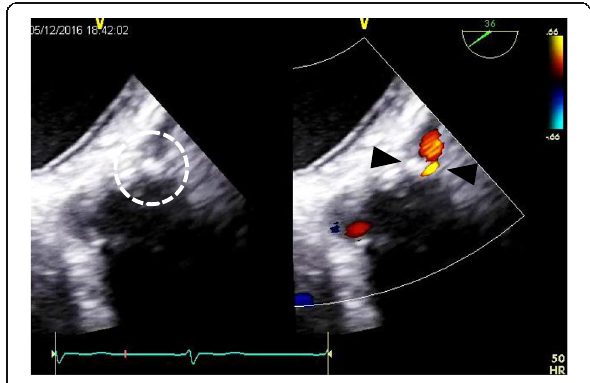
Fig. 3 Intraoperative transesophageal echocardiography. Left , a high- brightness massive shadow at the left coronary ostium ( dotted circle ). Right , color flow on Doppler showed a mosaic image and accelerated blood flow ( arrowhead